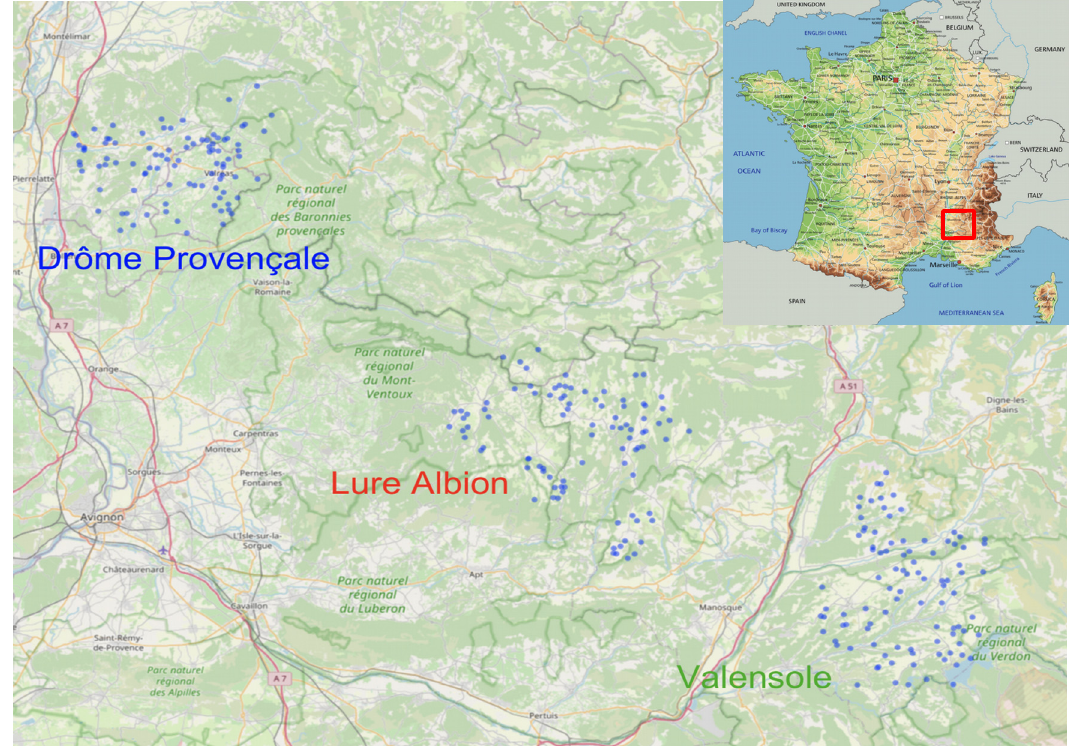
Figure 1. Map of the location of the apiaries surveyed during the 13 years. Each blue dot represents one apiary.